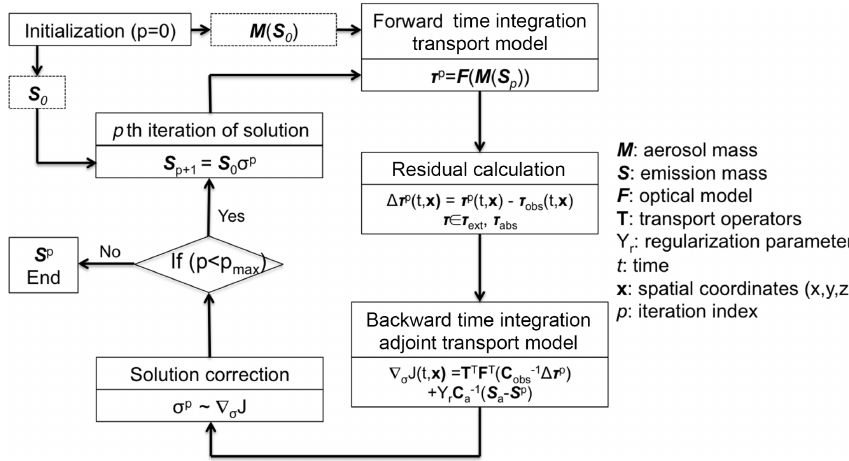
Figure 4. Diagram illustrating retrieval of aerosol emissions from satellite measurements.